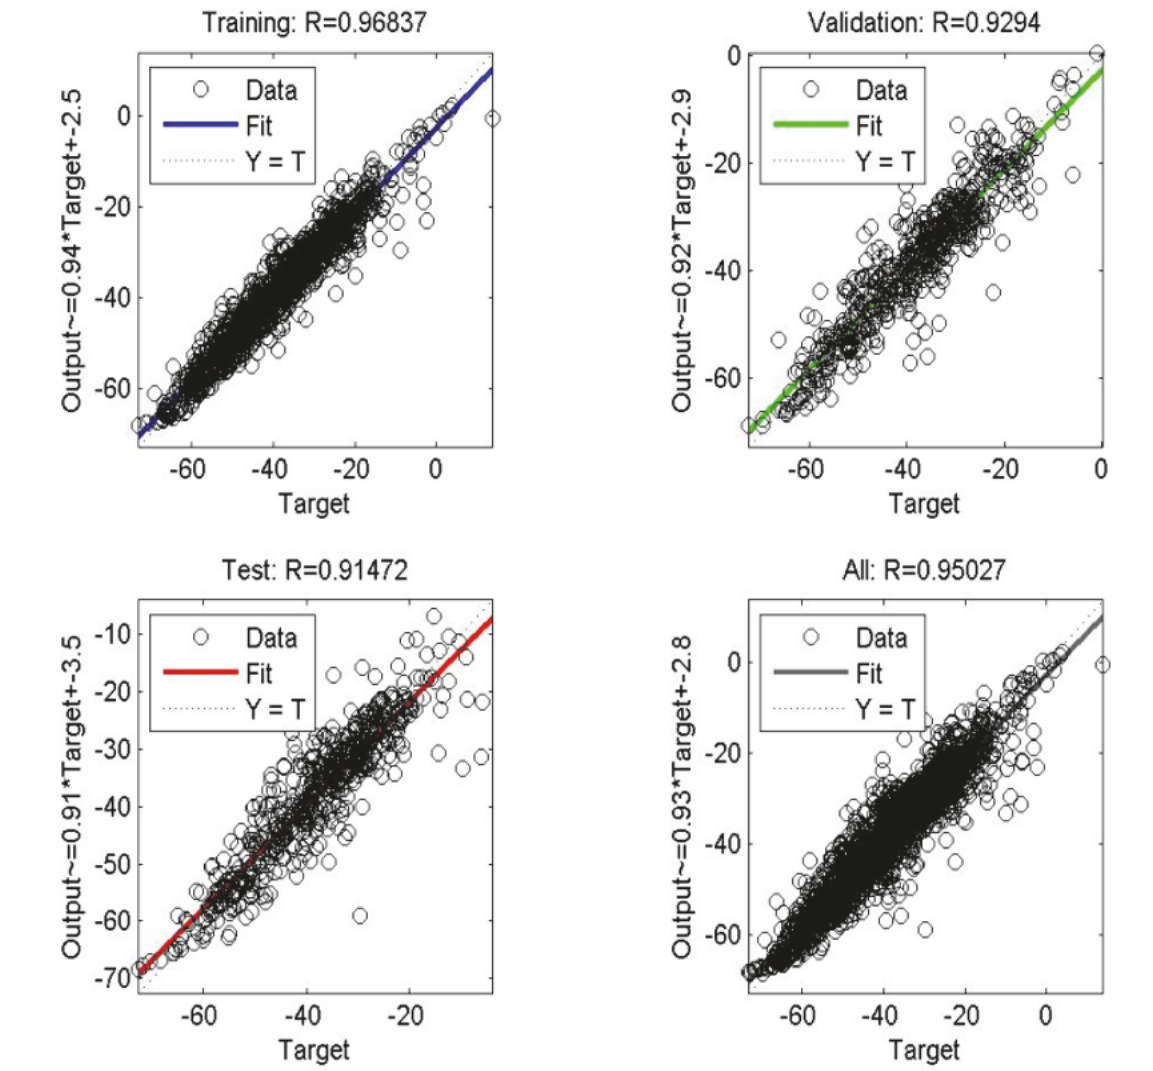
possibility of having values of anomalies for areas where they do not exist by giving the geographical